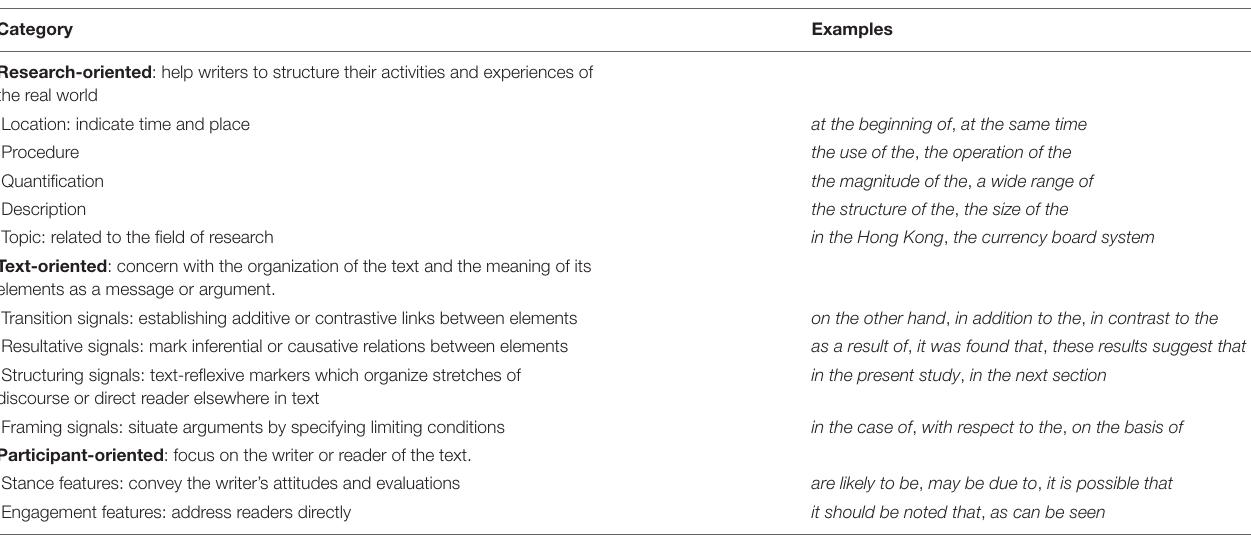
TABLE 2 | (Hyland, 2008a, p. 49) functional